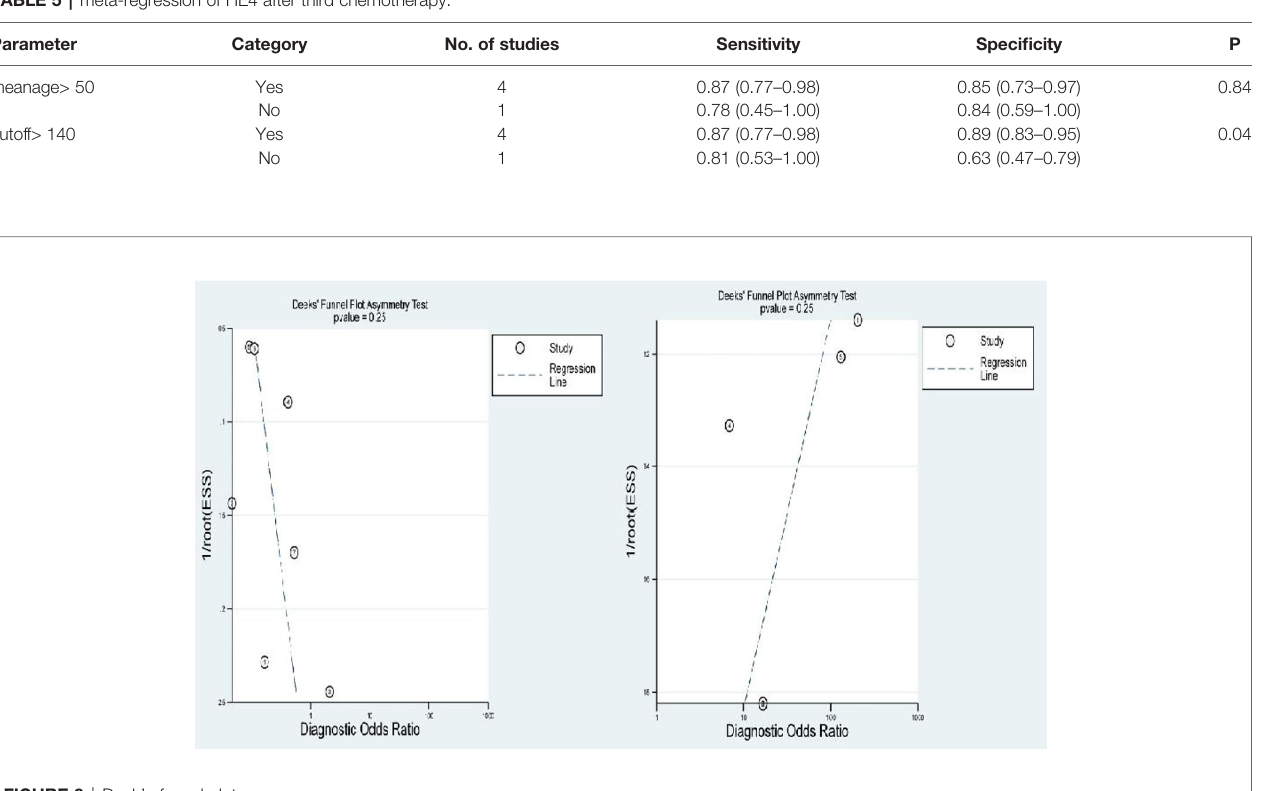
FIGURE 8 | Deek ’ s funnel